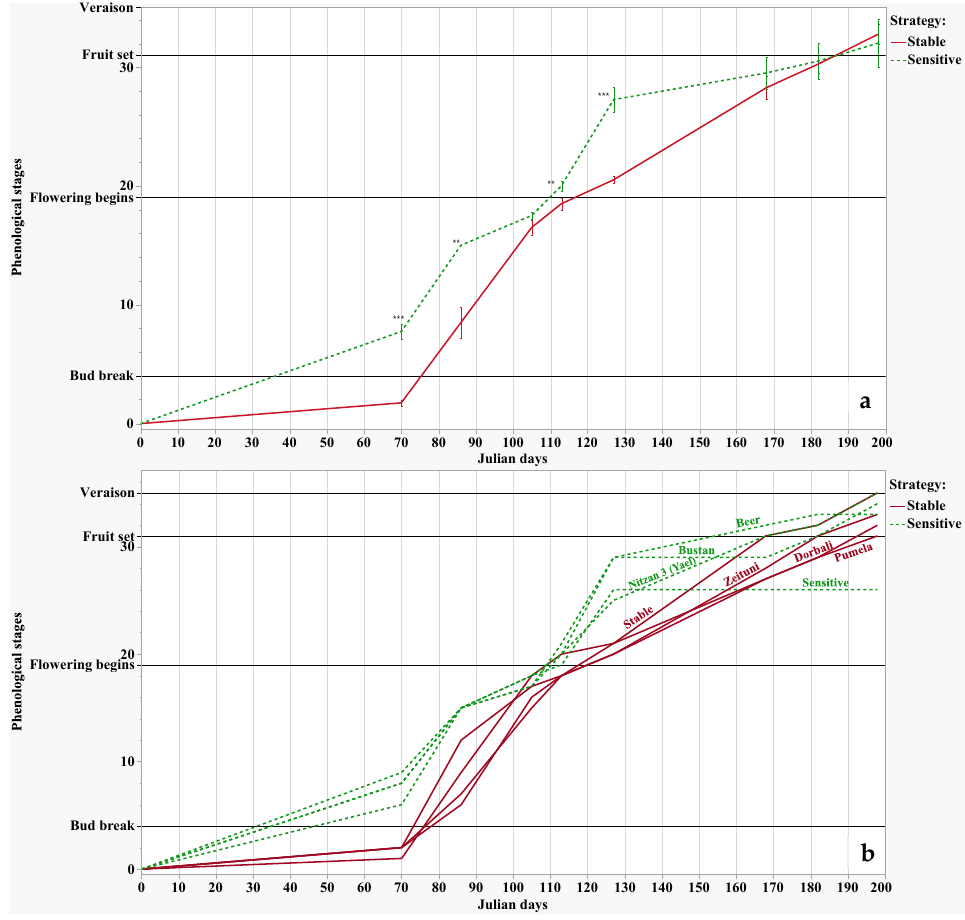
Figure 3. Phenological observations (bud break, flowering, fruit set, and veraison) of grapevine varieties during January to July. ( a ) Average performance for 8 stable species and 7 sensitive species. The statistical analysis we used was the t-test. ** t < 0.01, *** t < 0.001. ( b ) Specific phenological sequence for 4 sensitive (green) and 4 stable (red) varieties showing the highest differences in foliage